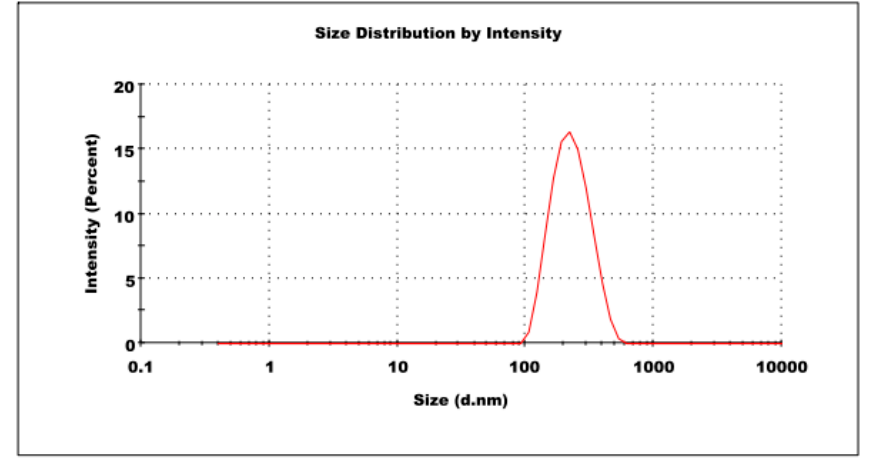
Figure 2. Particle size distribution of ASLNs.